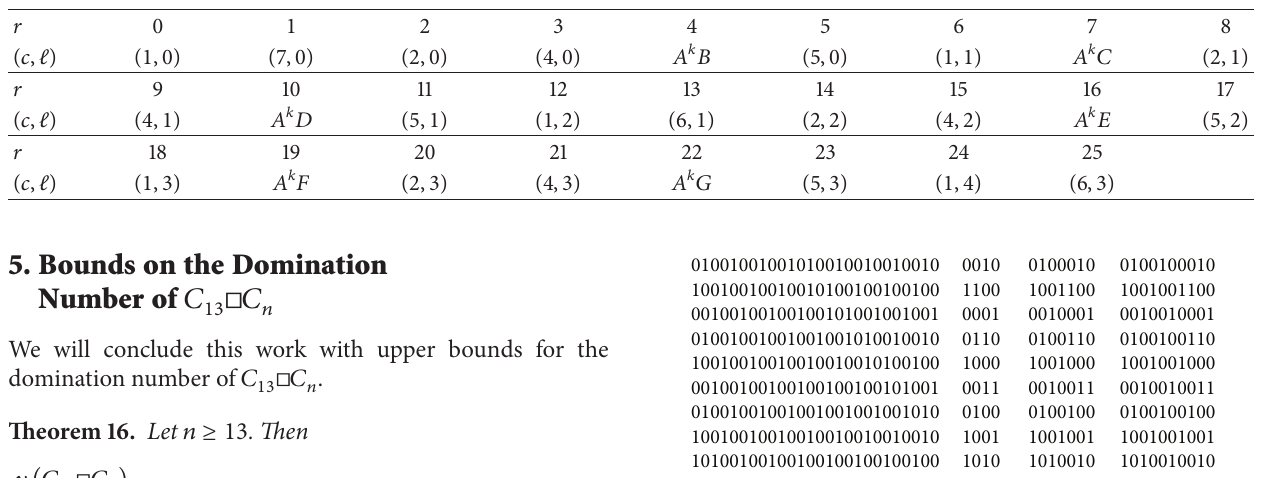
Table 1: Constructions for upper bounds of 𝐶 13 ◻𝐶 𝑛 .